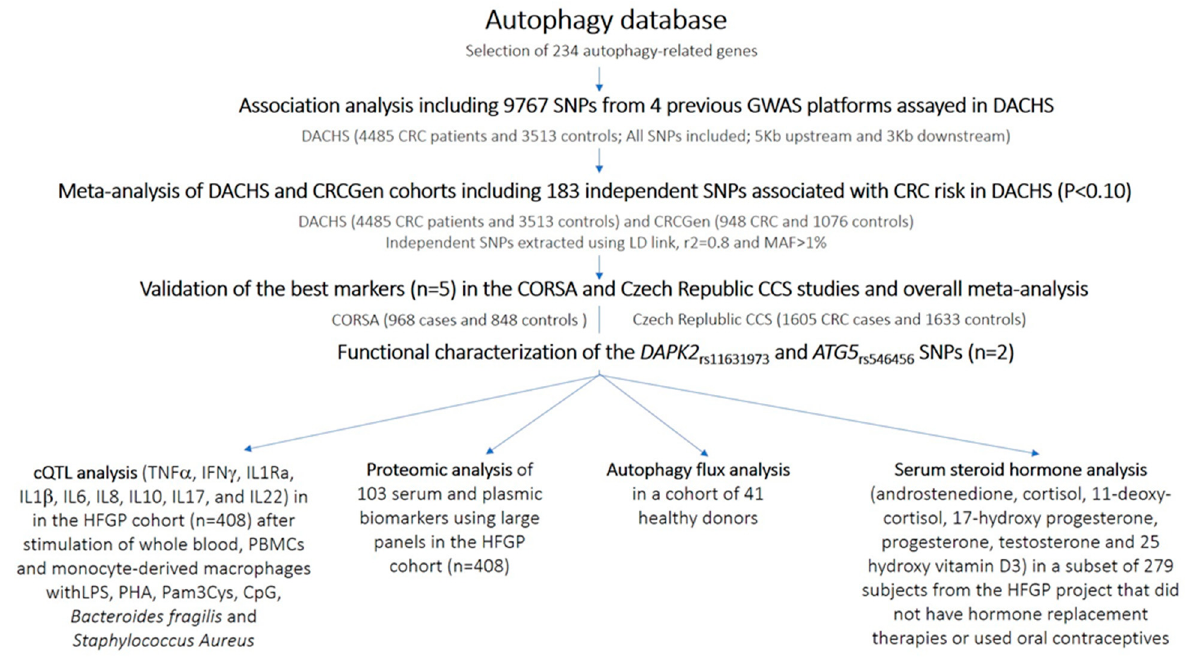
Figure 1. Flow diagram of the study.